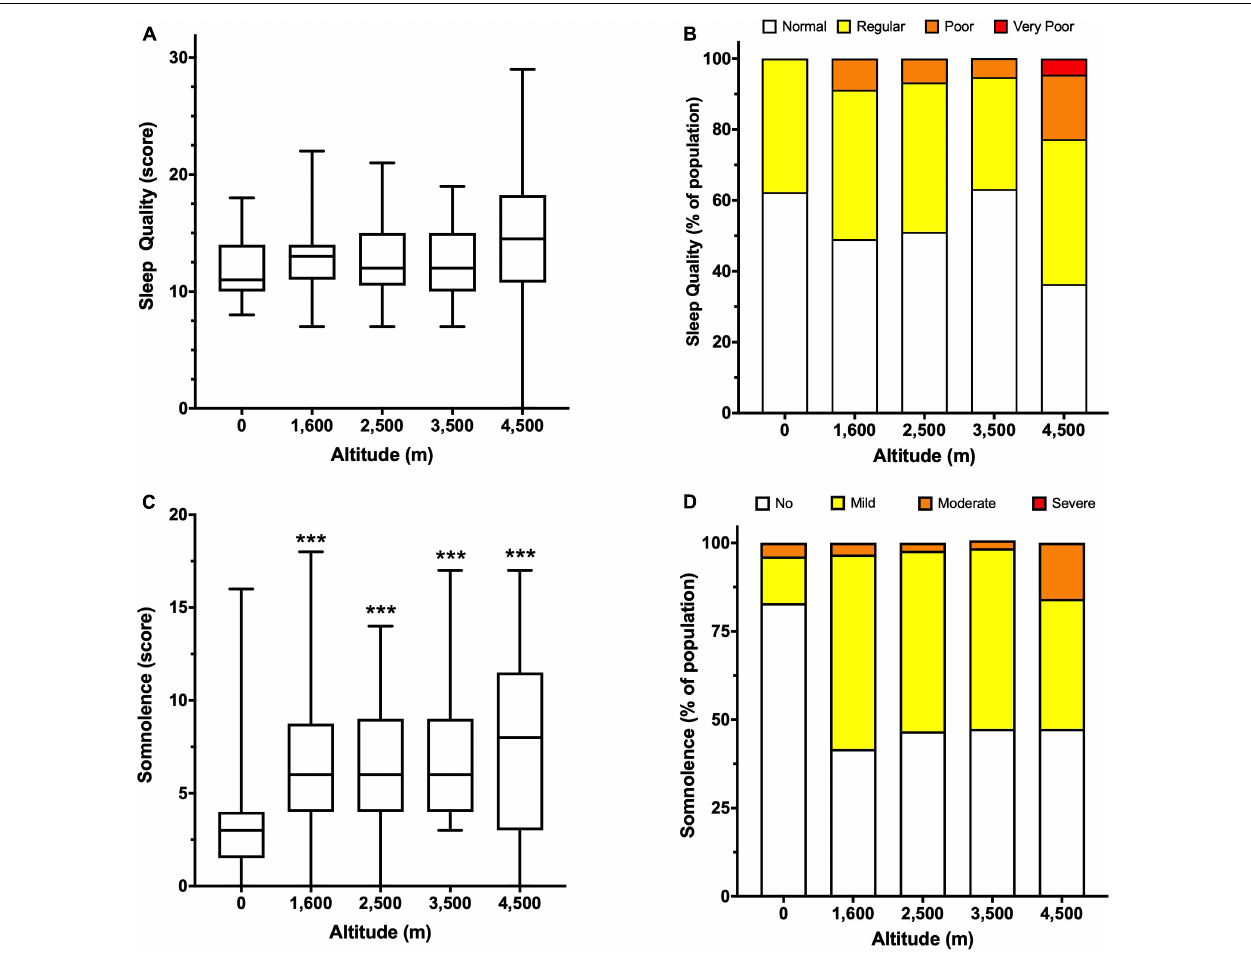
FIGURE 2 | Subjective evaluation of sleep quality and somnolence according to altitude. Sleep quality is expressed as a score (A) and percentage of people in the indicated category (B) . Somnolence is expressed as a score (C) and a percentage of people in the indicated category (D) . Data in panels (A,C) are presented as a box-and-whisker plot. Significant differences: *** p < 0.001 compared to the population at 0